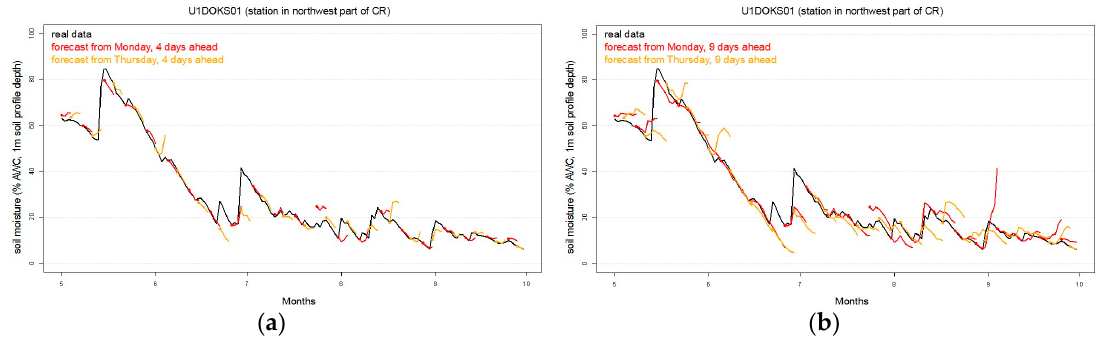
Figure 12. The course of soil moisture content (in % AWC) calculated from measured meteorological station data and the 4th day ( a ) and 9th day ( b ) forecasts developed periodically on Mondays and Thursdays in the evaluated part of the year 2017 at Doksany station.